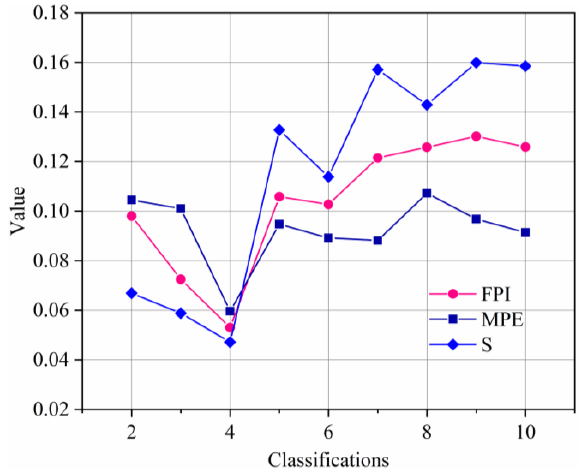
Figure 6. FPI, MPE and S values versus different numbers of classifications in the calibration dataset.